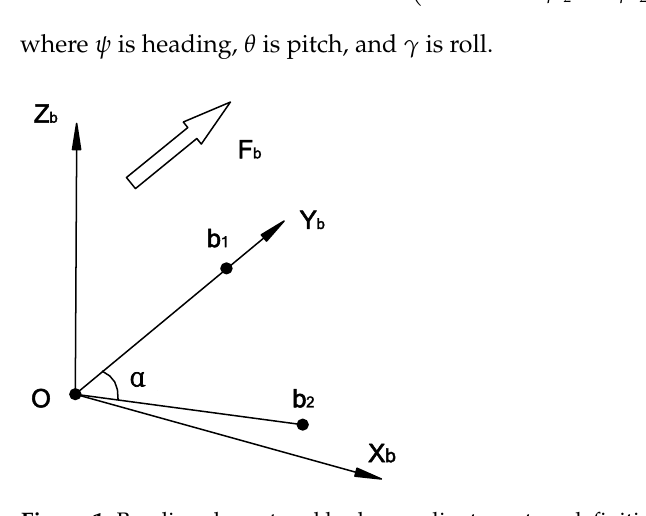
Figure 1. Baselines layout and body coordinate system definition. In this paper, the three-antenna GNSS multi-baseline model is adopted. No redundant observation is considered. The direct method is particularly applicable in this study because of its simple form and small computing